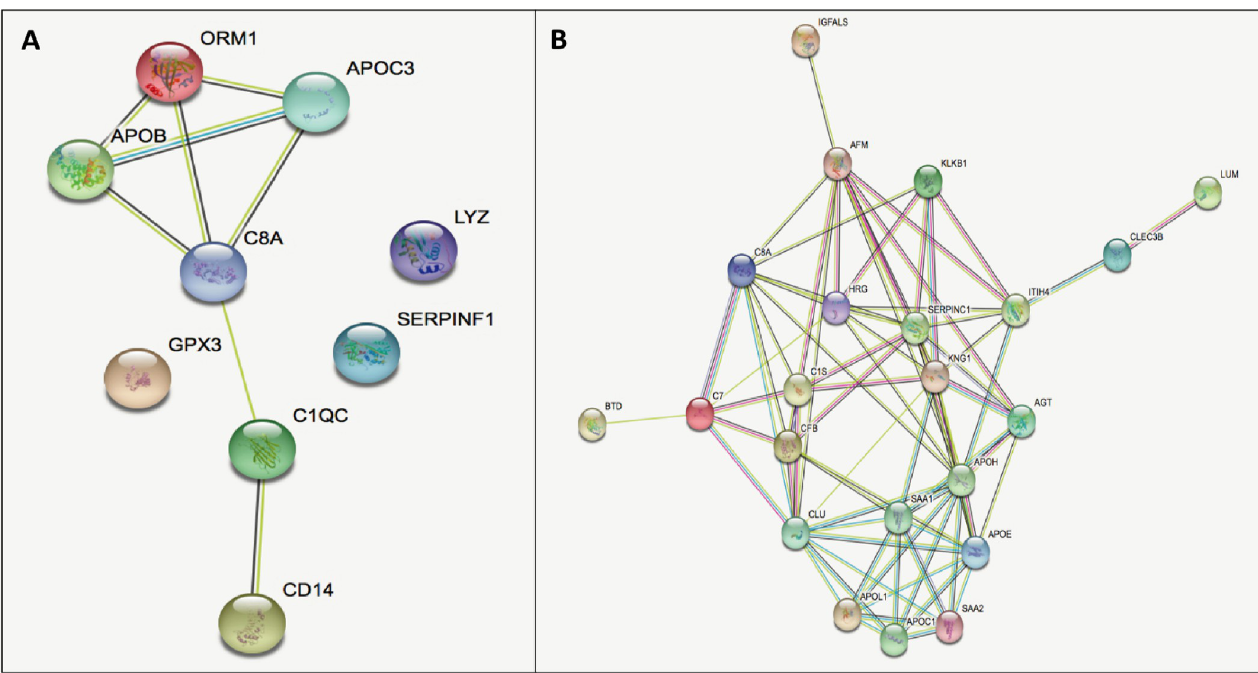
Fig 1. Relationship between proteins (strings): A) organ dysfunction, B) Mortality (https://string-db.org/).